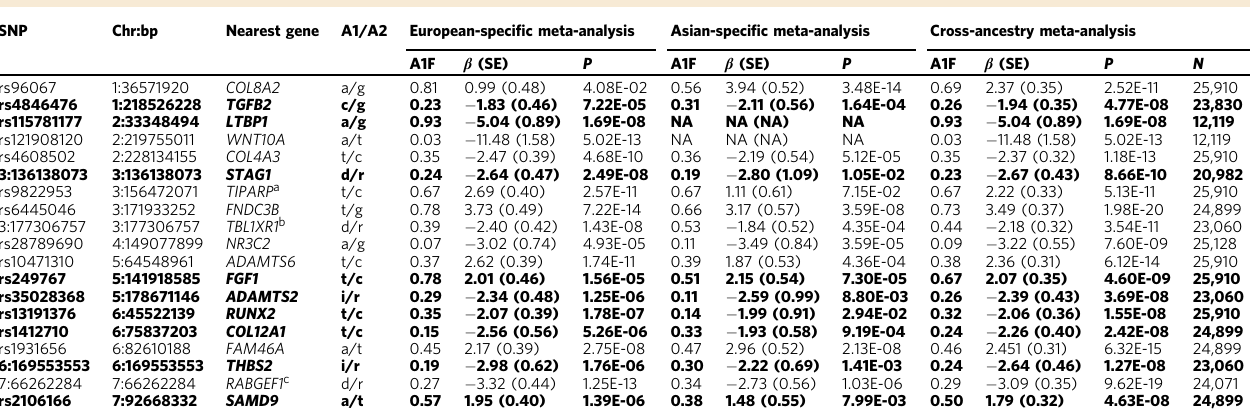
Table 1 Results from cross-ancestry meta-analysis (chromosomes 1 –